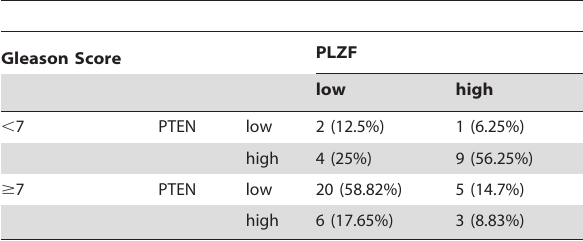
Table 1. Frequency of PLZF expression in human prostate cancer specimen.